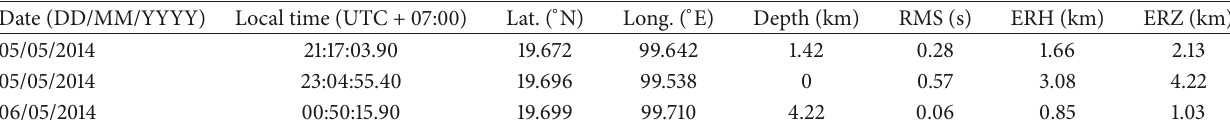
Table 1: Hypocentres calculated by HYPOINVERSE computer program.